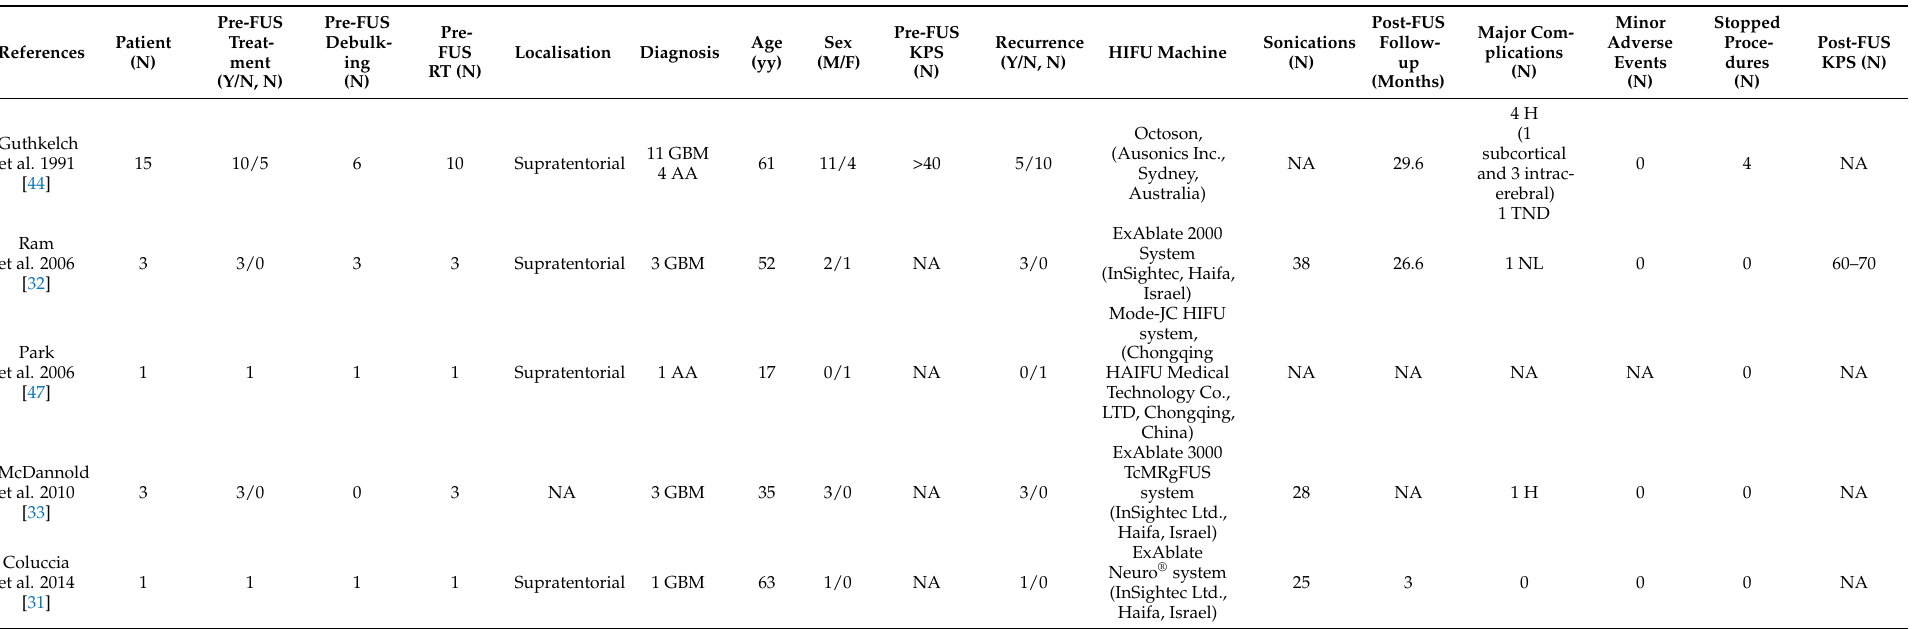
Table 3. Overall Tumor Ablation via FUS patient demographics, preoperative status and post-operative